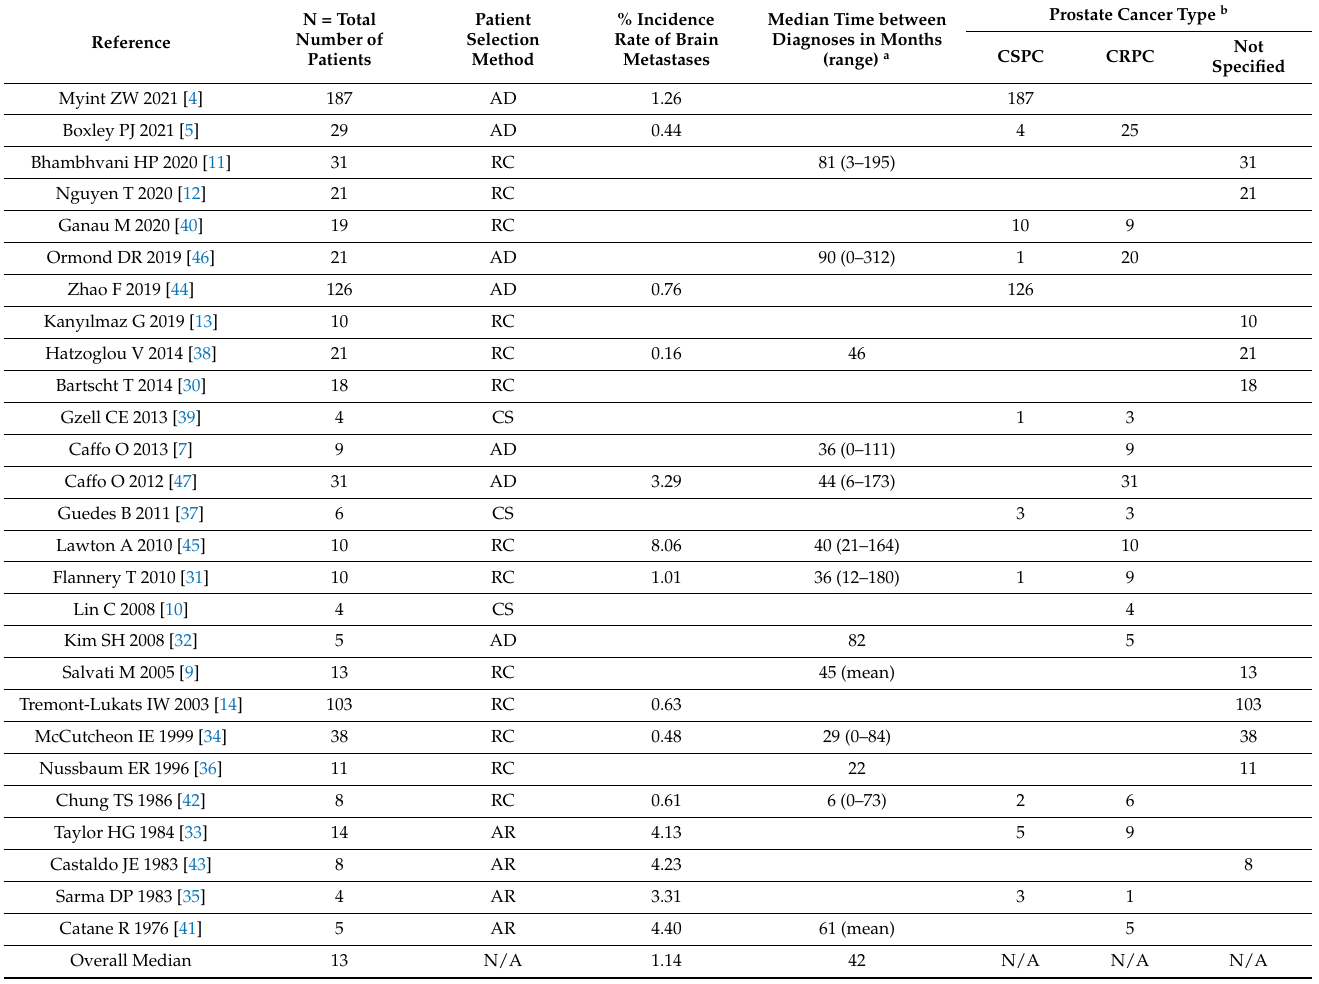
Table 1. Study and patient